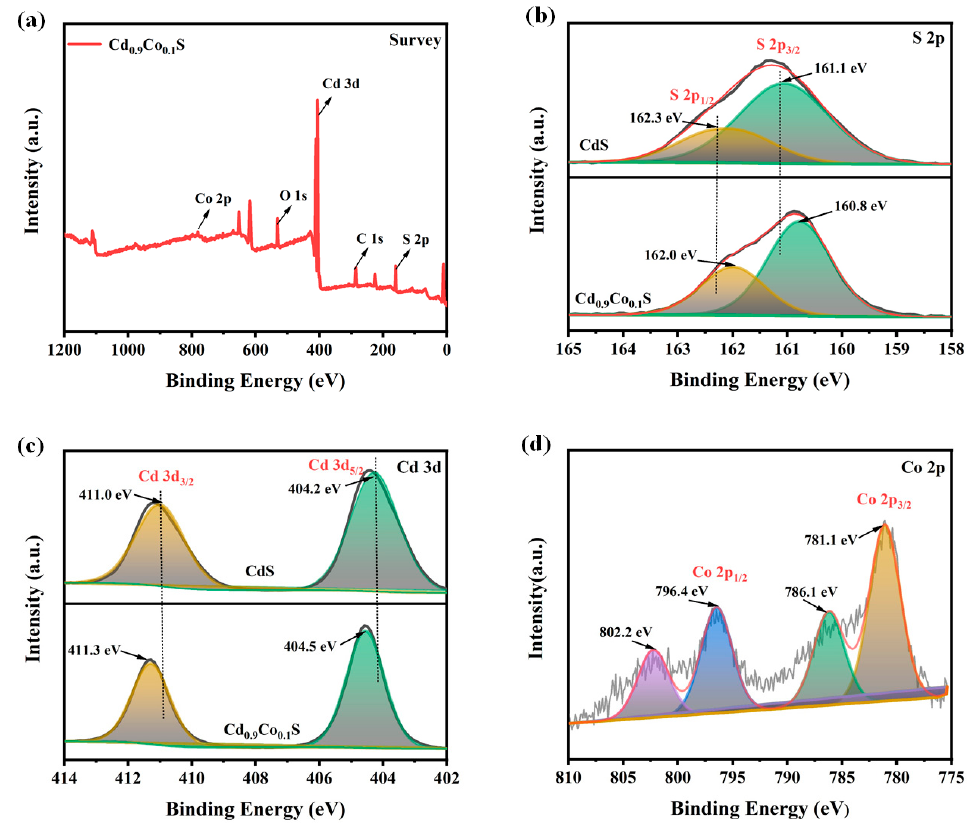
Figure 3. XPS survey spectra of Cd 0.9 Co 0.1 S NRs ( a ), and high-resolution XPS spectra of: S 2p ( b ), Cd 3d ( c ) in the CdS and Cd 0.9 Co 0.1 S NRs, and Co 2p ( d ) in the Cd 0.9 Co 0.1 S NRs.